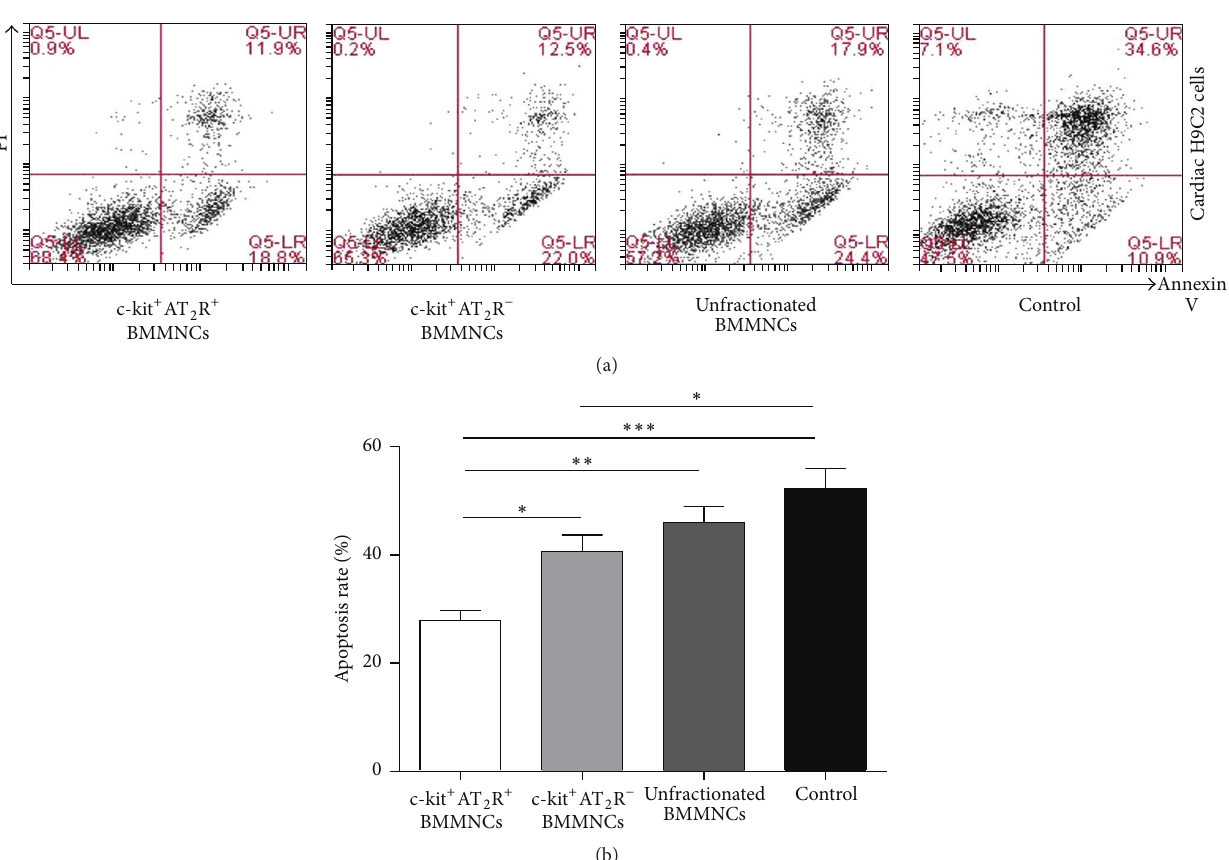
Figure 3: Apoptotic rate of cardiac H9C2 cells. (a) Annexin V/PI staining of cardiac H9C2. (b) Apoptotic rate of cardiac H9C2 cells ( ∗ 𝑝 < 0.05, ∗∗ 𝑝 < 0.01, and ∗∗∗ 𝑝 < 0.001; values are means ± SEM; BMMNCs subsets, 𝑛 =